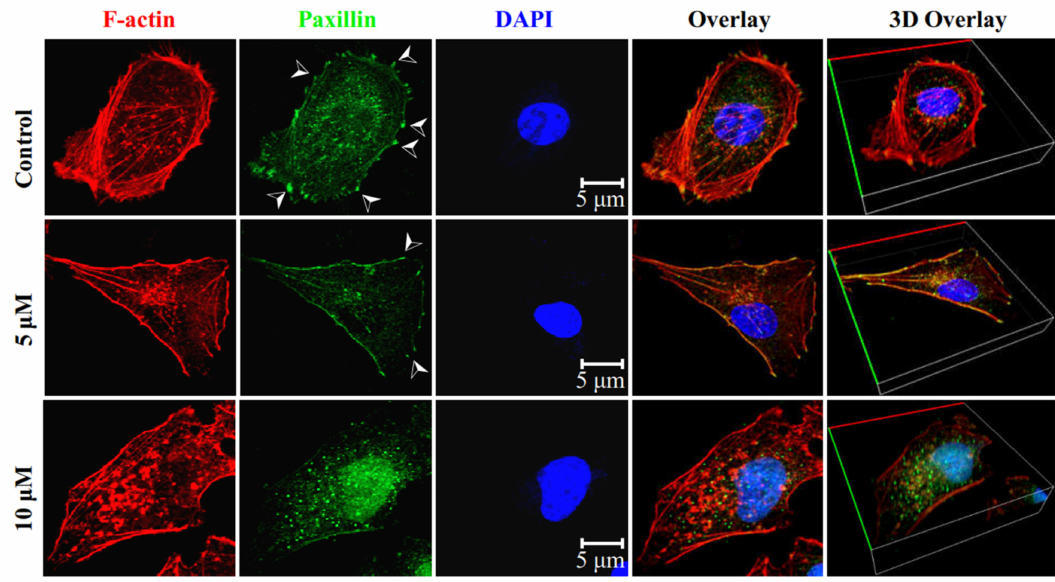
Figure 6. The inhibition of the invadopodia formation of MDA-MB-231 cells induced by ∆ − 3 . The immunofluorescence of Paxillin (green) and F-actin (red) in MDA-MB-231 cells after dealt with ∆ − 3 (0, 2.5, 5, and 10 µ M) for 24